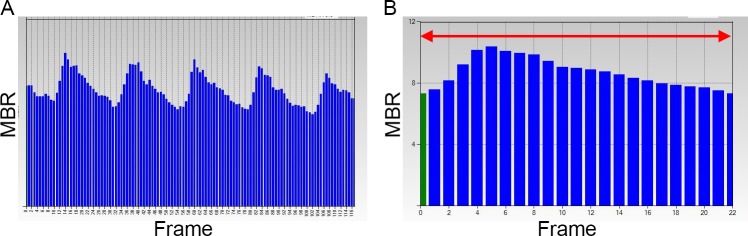
Measurement of avearge mean blur rate with LSFG.(A) Pulse waves recorded by LSFG showing the fluctuations in the MBR of the choroidal blood flow during each cardiac cycle for 4 seconds. The total number of frames is 118 in onescan. (B) Synthesized MBR image showing the average fluctuation in the MBR in one heartbeat. The red arrow indicates one heartbeat.